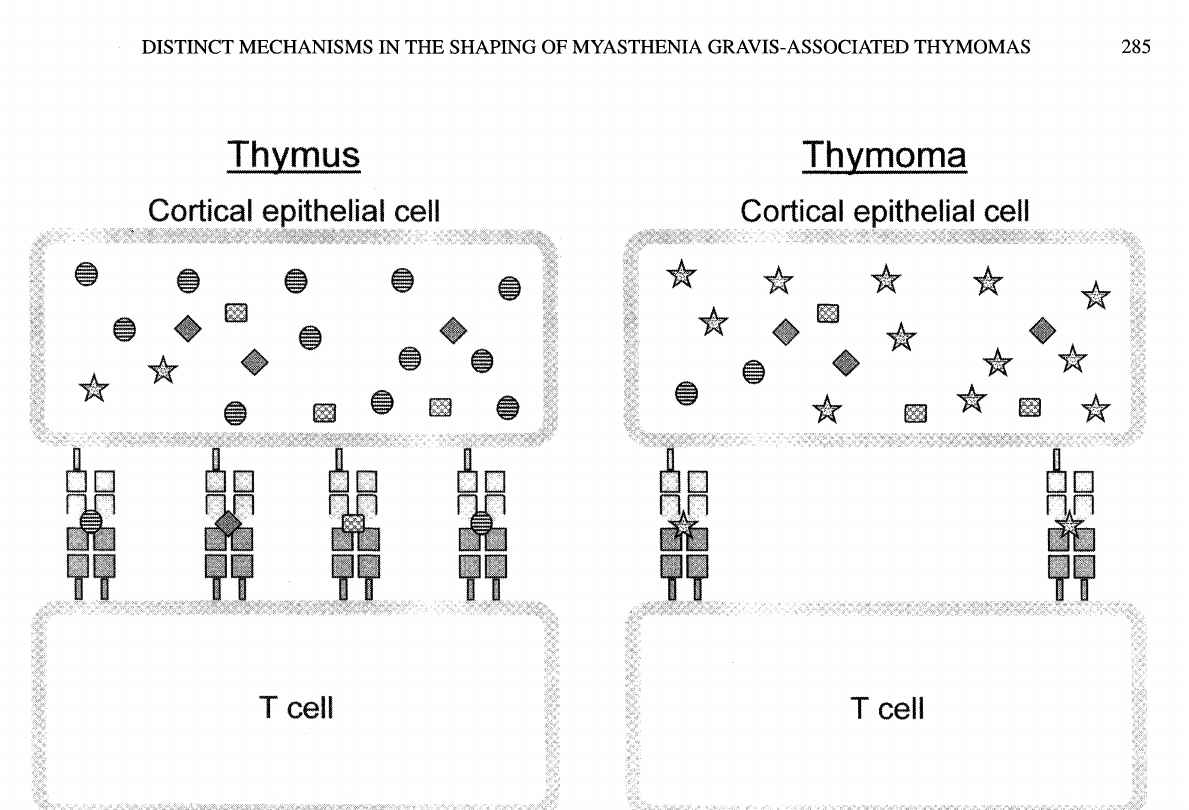
et al. 1996). However, MHC-independent